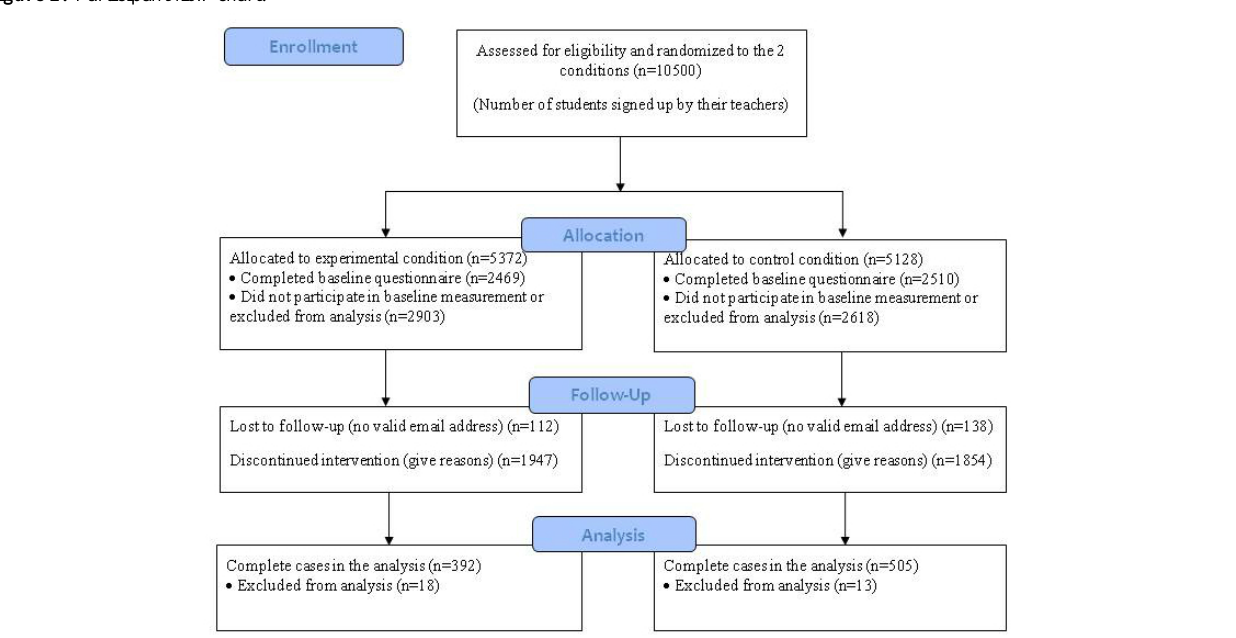
Figure 2. Participant flow